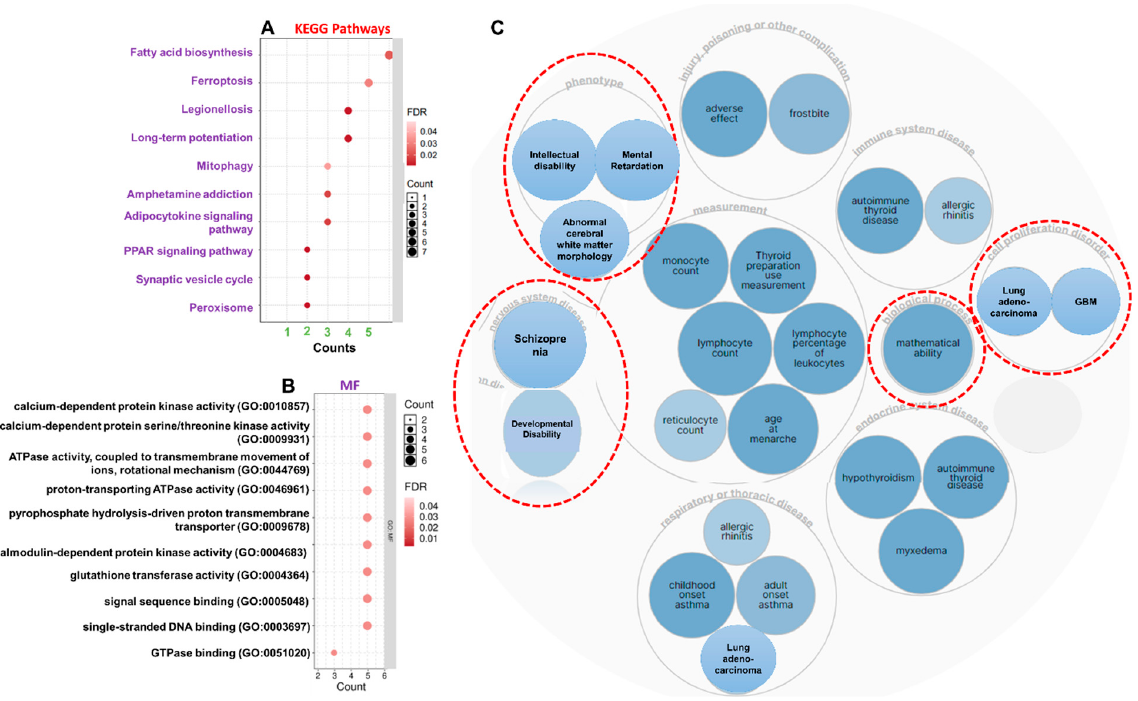
Figure 6. ATP6V1A/BNIP3 and CAMK4/TIPRL/TOMM70 are associated with several pathways and processes associated with brain functioning and disabilities. ( A ) KEGG pathways and ( B ) molecular function enrichment of ATP6V1A/BNIP3 and CAMK4/TIPRL/TOMM70. ( C ) Bubble plot showing the gene – disease association network of the gene set. GBM; glioblastoma multiforme. Table 3. Biological processes enriched by the target genes.